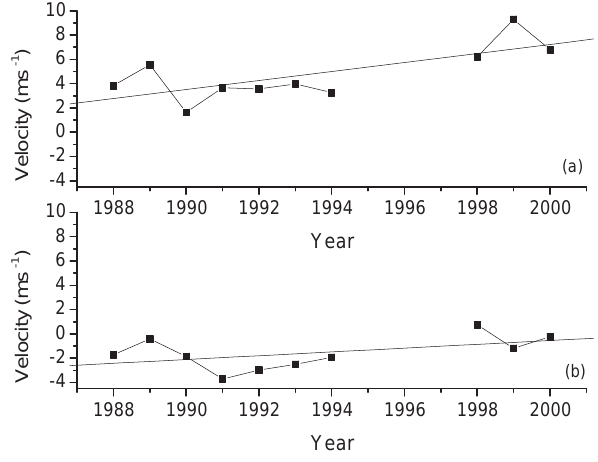
Fig. 6. Annual-mean winds: a) Zonal, b) Meridional and associated linear